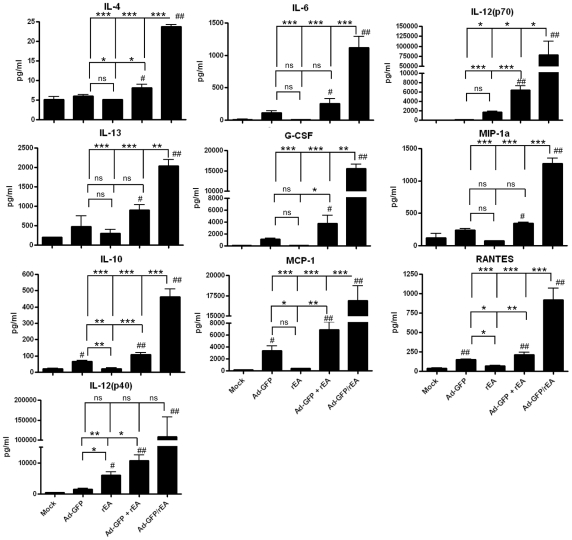
Heightened Ad-GFP/rEA induced cytokine responses.(A) C57BL/6 mice were mock injected (n = 4), or IV injected with 7.5×1010 vps of Ad-GFP, 1 ng purified rEA protein, a mix of Ad-GFP and rEA protein, or Ad-GFP/rEA. Plasma was harvested and cytokines and chemokines were measured at 6 hpi (n = 5-10). Bars represent mean ± SE. #, ## represent significantly different from mock injected animals (p<0.05, p<0.01 respectively). *,**, *** represent statistical differences (p<0.05, p<0.01, p<0.001, respectively). ns, not significant.